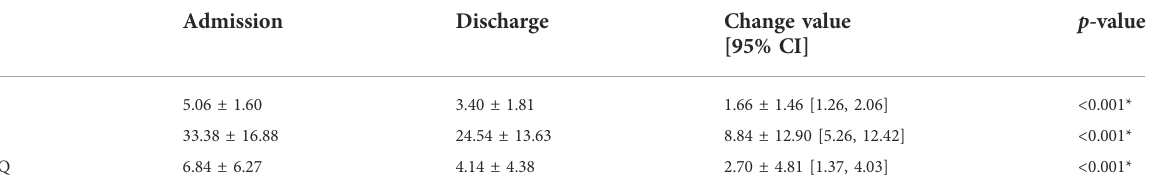
TABLE 3 Change of VNRS, K-ODI, K-RMDQ value (N = 50).